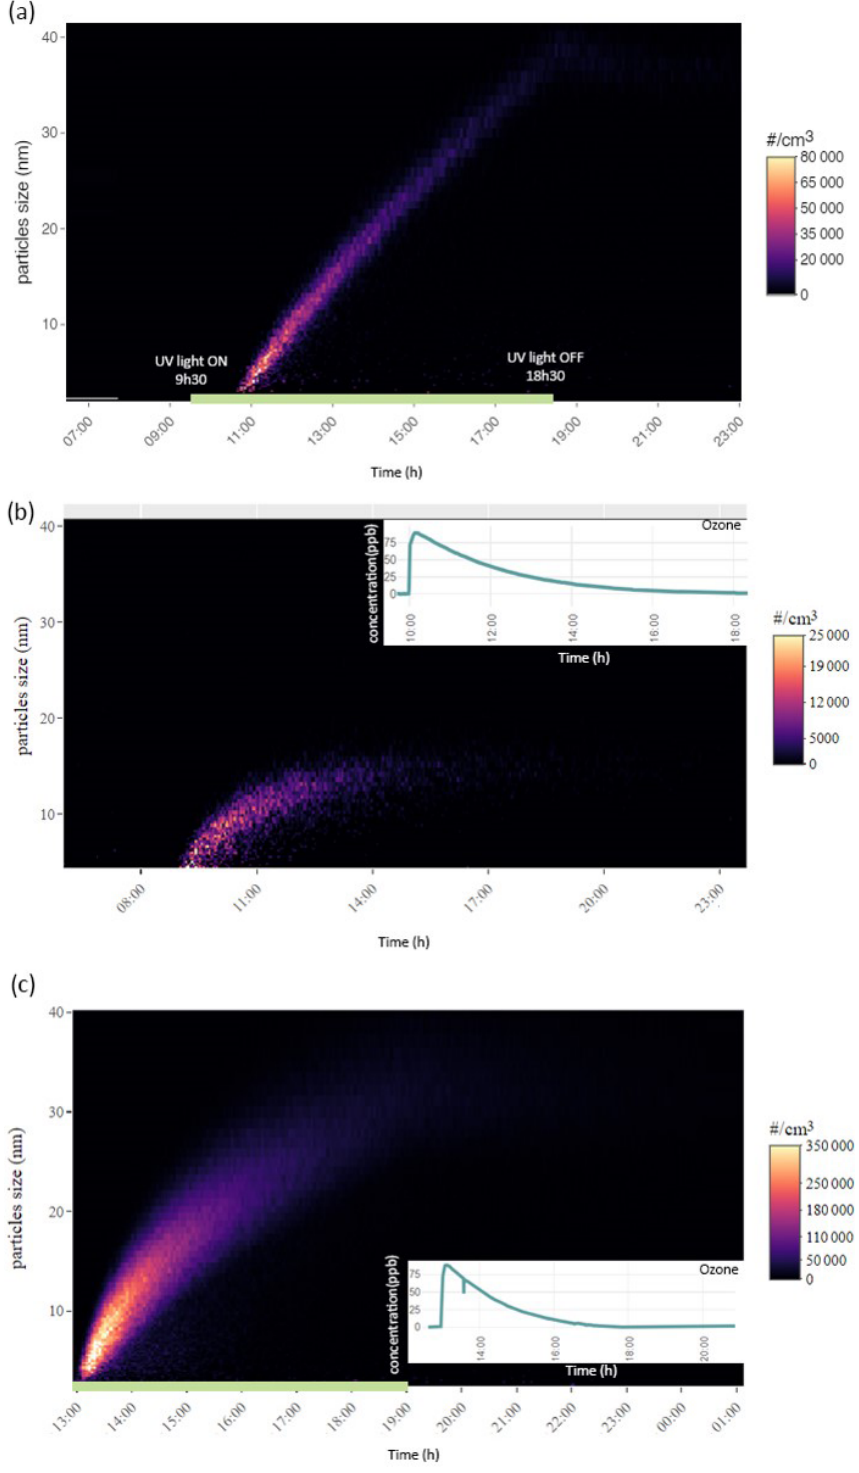
Figure 6. Temporal evolution of particle number and size distribution, ordinate represents the electrical mobility diameter (nm) and the colour scale the particle number concentration. Particle formation for the first day of measurement under (a) UV light irradiation, (b) ozone injection and (c) UV light irradiation and ozone injection combined. The green horizontal line represents the timeline where the UV light were switched on for (a) the UV light have been turned on at 09:30LST and turned off at 18:30LST, for (c) the UV light have been turned on at 12:30LST and turned off at 19:00LST. Panels (b) and (c) also display the ozone concentration timeline during the particle